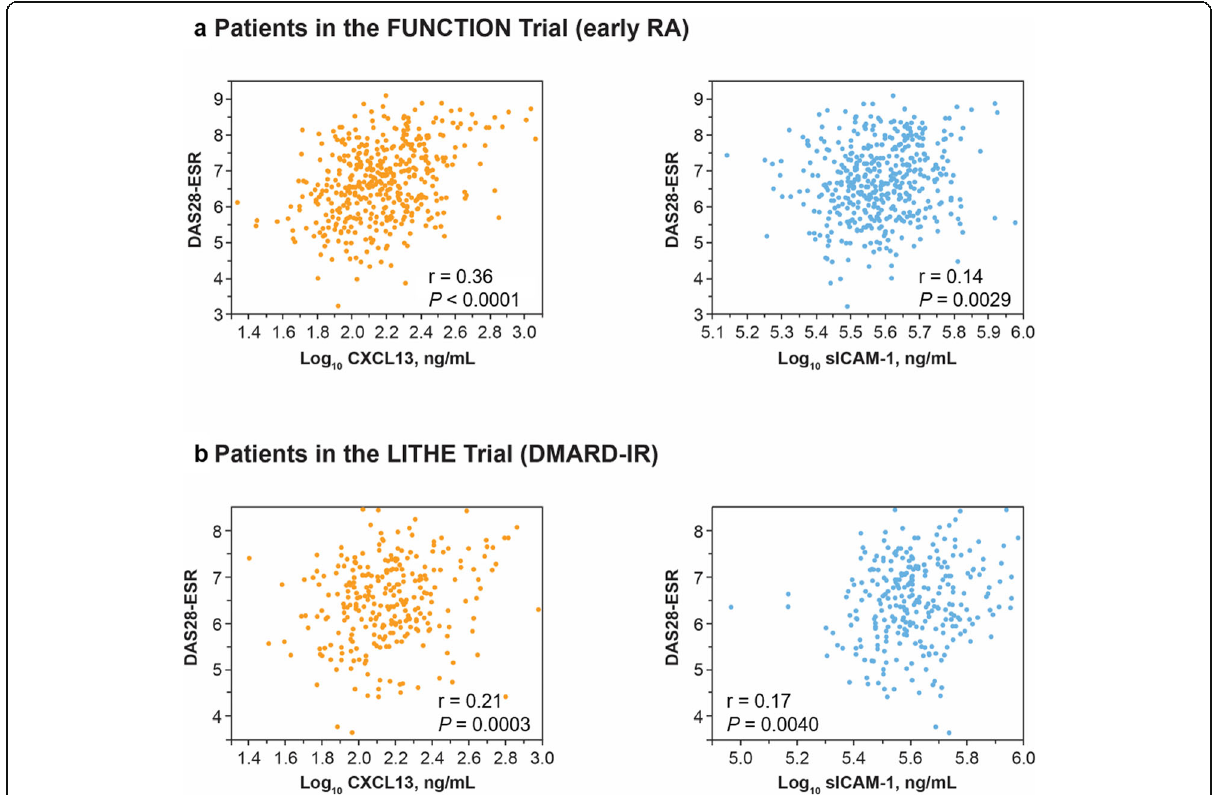
Fig. 1 Correlation Between Serum CXCL13 and sICAM-1 Levels and DAS28-ESR at Baseline. a Patients in the FUNCTION trial (early RA). b Patients in the LITHE trial (DMARD-IR). CXCL13, C-X-C motif chemokine ligand 13; DAS28-ESR, Disease Activity Score in 28 joints calculated with erythrocyte sedimentation rate; DMARD-IR, inadequate response to disease-modifying antirheumatic drugs; RA, rheumatoid arthritis; sICAM-1, soluble intercellular adhesion molecule-1